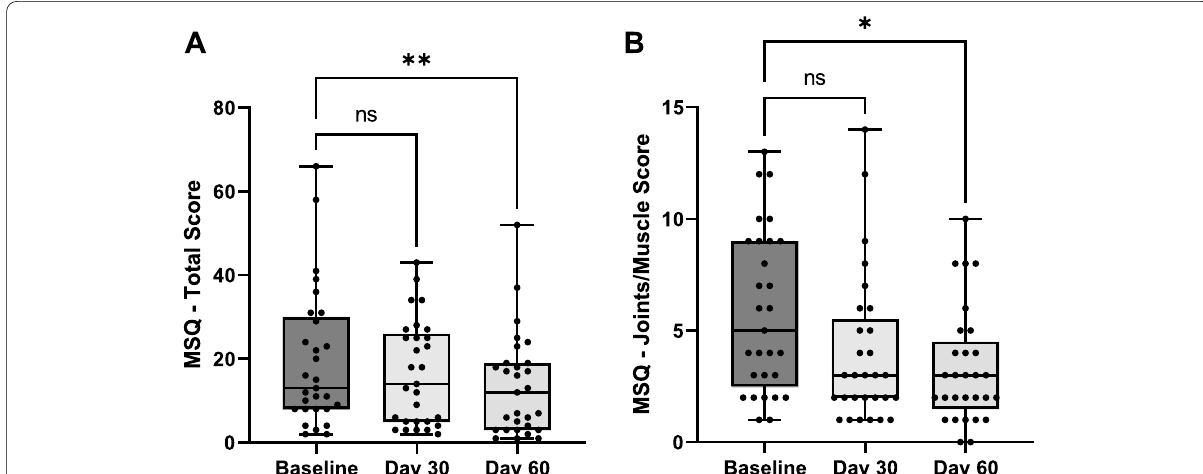
Fig. 4 Medical Symptoms Questionnaire represented as box and whisker plots. Statistical analyses were performed using the non‑parametric Friedman test followed by the Dunn’s multiple comparison post‑hoc test to identify changes from baseline. The following denotes the level of statistical significance; ns p > 0.05, * p < 0.05, ** p < 0.01 ( n =